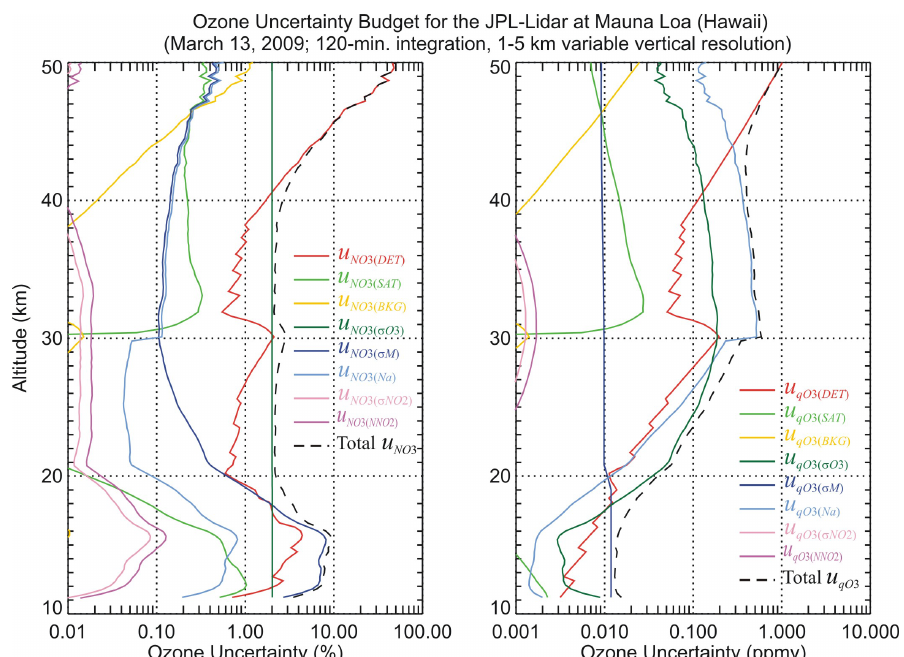
Figure 16. Example of ozone relative uncertainty (left) and mixing ratio uncertainty (right) budget computed for the JPL stratospheric ozone DIAL located at Mauna Loa Observatory (Hawai’i) using the standardized approach presented in this work (nighttime measurements).